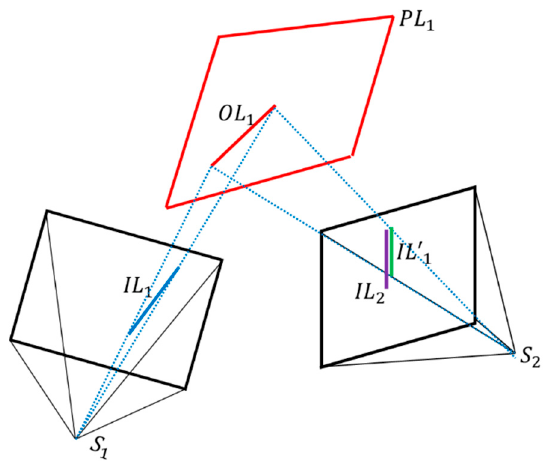
Figure 4. Illustration of using objective planar surfaces as initial constraints in feature line matching